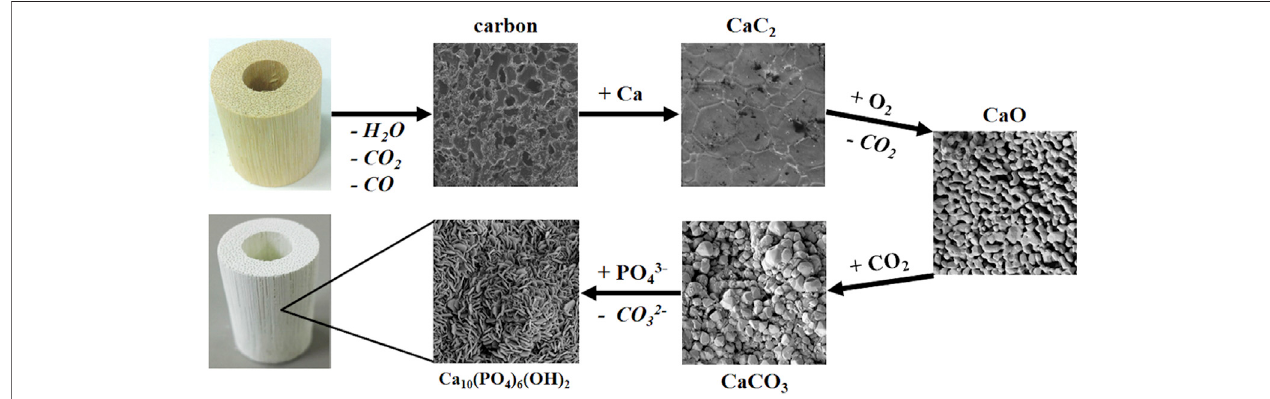
FIGURE 1 | Scheme of the multi-step biomorphic transformation process (Images magni fi cations: carbon 5000X; calcium carbide, calcium oxide, calcium carbonate and hydroxyapatite 25000X).